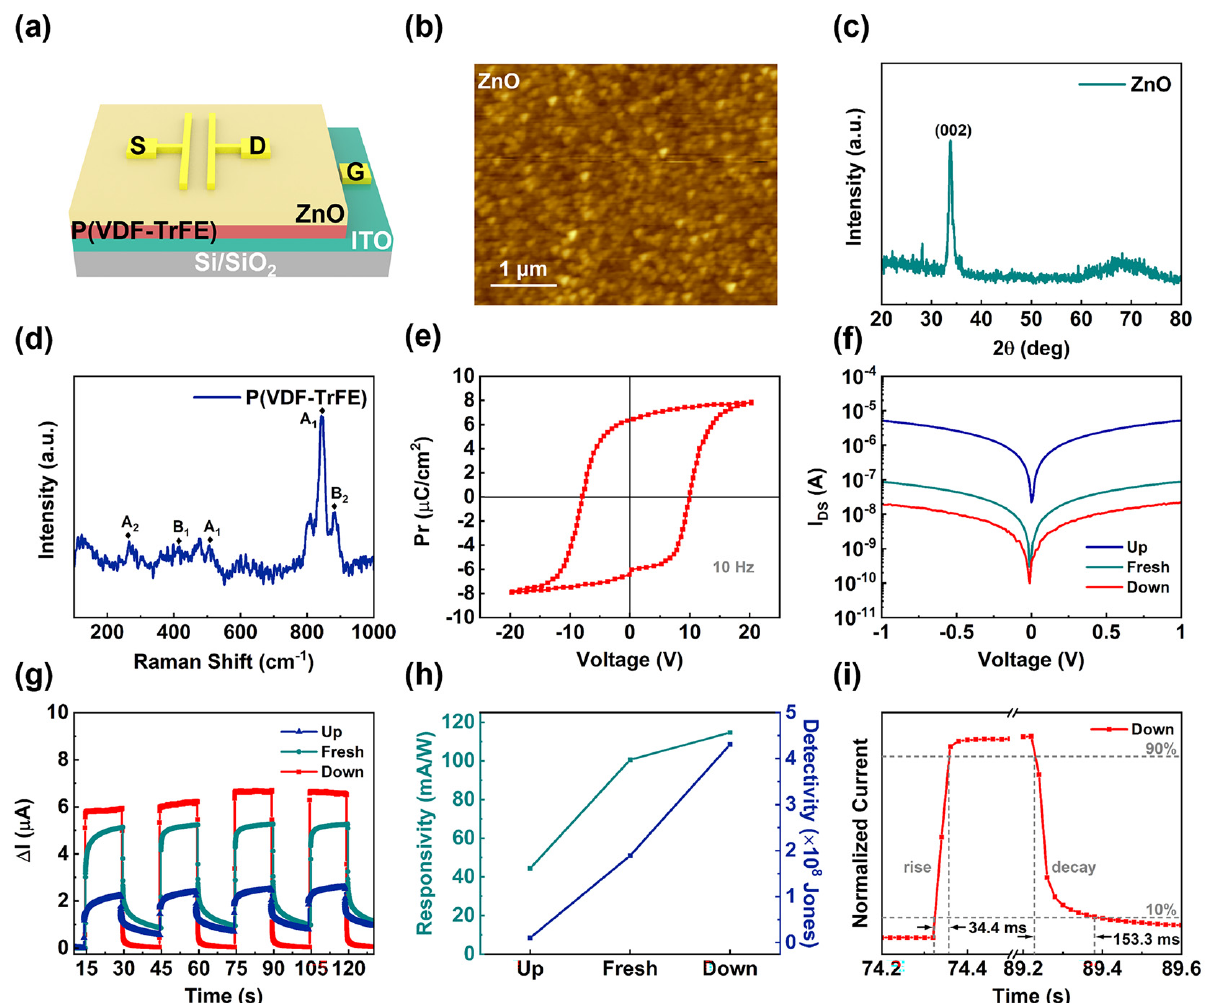
Figure 4. ( a ) Schematic diagram of the structure of the ZnO film Fe–FET device. ( b ) Atomic force microscopy (AFM) topological images of the ZnO films. ( c ) XRD patterns of the ZnO film. ( d ) Raman spectra of the P(VDF–TrFE) film. ( e ) The ferroelectric hysteresis loop of the P(VDF–TrFE) film capacitor, measured with a Sawyer–Tower circuit at a frequency of 10 Hz. ( f ) The I DS –V DS output characteristics with three ferroelectric layer states. ( g ) The ∆ I–t characteristic curves of the device with three states of a ferroelectric layer at V DS = 1 V. ( h ) The responsivity and detectivity of the device at three ferroelectric layer states. ( i ) The response time of the device at a power intensity of 50 mW/cm 2 in the Down state.